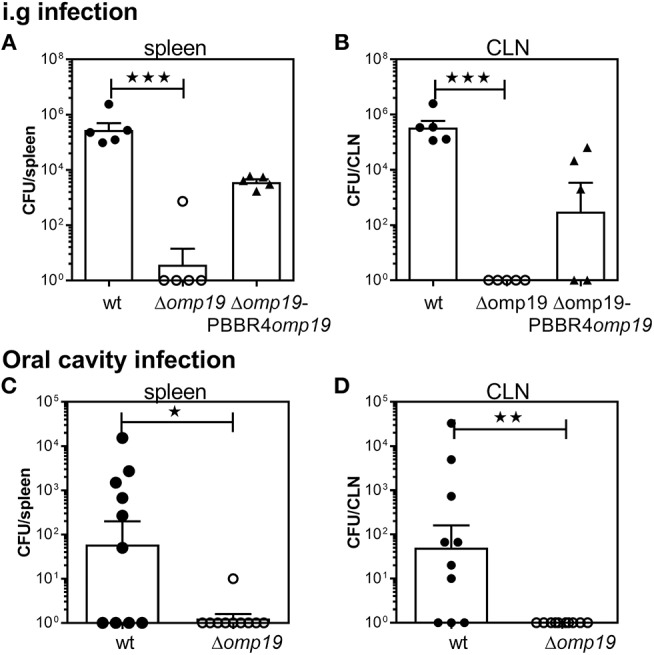
B. abortus Δomp19 is attenuated after oral infection. (A,B) BALB/c mice were i.g. inoculated with 1 × 109 CFU/mouse of wt, Δomp19 or Δomp19pBBR4omp19 B. abortus strains. Spleen and CLNs were homogenized and plated for CFU counting at 20 days post-infection (***p < 0.001 vs. wt B. abortus). Results are representative of three independent experiments with 5 mice per group. (C,D) BALB/c mice were inoculated at the oral cavity with wt or Δomp19 B. abortus (1 × 1010 CFU/mouse). Twenty days after infection the number of CFU at the spleens and CLNs were quantified (*p < 0.05 and **p < 0.01 vs. wt B. abortus). Pooled data from two independent experiments are shown. Each point represents data from an individual mouse. Horizontal lines and error bars represent the mean ± s.e.m. (For some mice, no live bacteria were recovered from spleens or CLNs. These were arbitrarily assigned with values of 1 CFU).